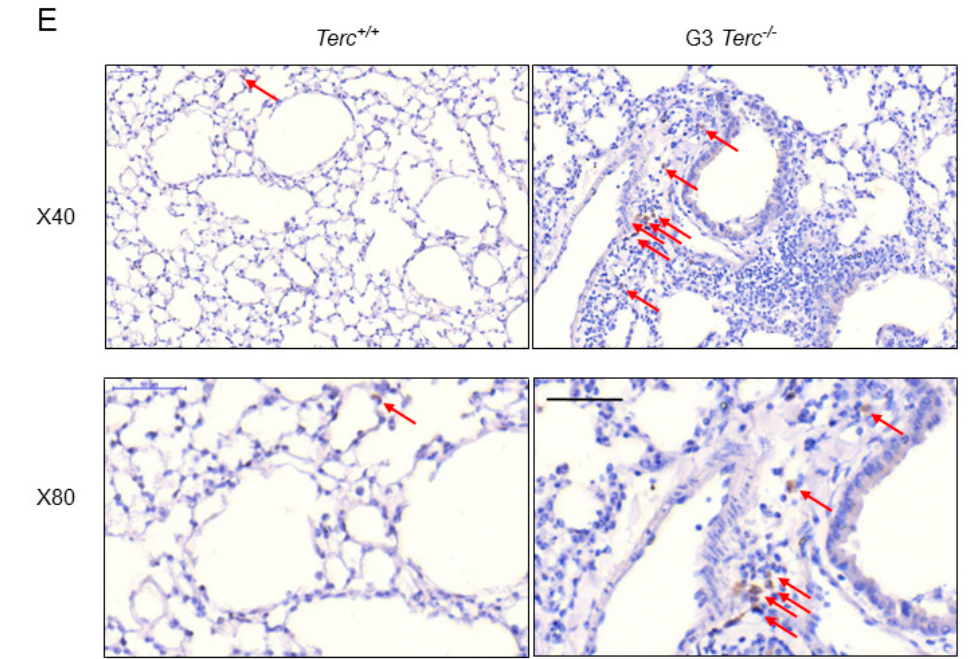
Figure 2. Significant increases in SA- β -gal staining, expression of cell cycle inhibitor p21, lysosomal β -galactosidase-associated GLB1, and natural killer cell marker NK1.1 in G3 Terc − / − mouse lungs. ( A ) Representative SA- β -gal-stained lungs of Terc +/+ and G3 Terc − / − (magnification: 20×). Scale bar = 100 μ m. ( B ) Quantification of SA- β -gal-stained cells by cell counting (as in A). Data are mean ± SE values based on the indicated number of lungs. ( C ) qPCR analysis of the indicated genes with RNA isolated from the indicated number of lungs by determining the relative mRNA level (ratio to β -actin). ( D ) Western blotting analysis with proteins from the lung tissues. ( E ) Representative NK1.1-stained lungs of Terc +/+ , G3 Terc − / − (magnification: 40× and 80×). Scale bar = 50 μ m. ( F ) The analysis of lung weight change by calculating the ratio to body weight based on the indicated number of mice. Statistical significance is indicated by * p < 0.05, ** p < 0.01, *** p < 0.001.